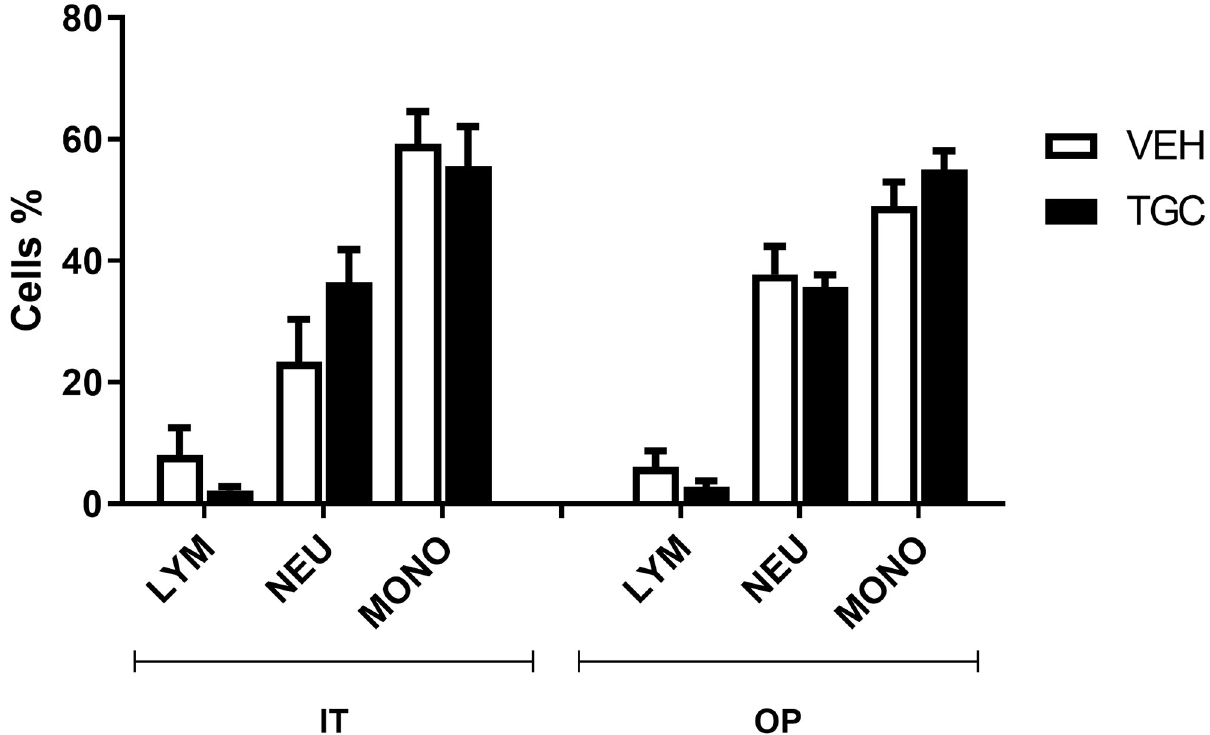
Fig 3. Lung infiltrating leukocytes in immunocompromised mice, upon IT or OP infection with A . baumannii ACC001. Lung BALF Leukocyte sub-population distribution, in intratracheally (IT) or oropharyngeally (OP) infected mice, treated with vehicle (VEH) and tigecycline (TGC) 120 mg/ day. Data expressed as percentage (%) ± SD of total Leukocytes. Abbreviations. LYM: Lymphocytes; NEU: Neutrophils; MONO: Monocytes. Statistical analysis was performed by by two tailed Student’s T test considering significant p � 0.05.